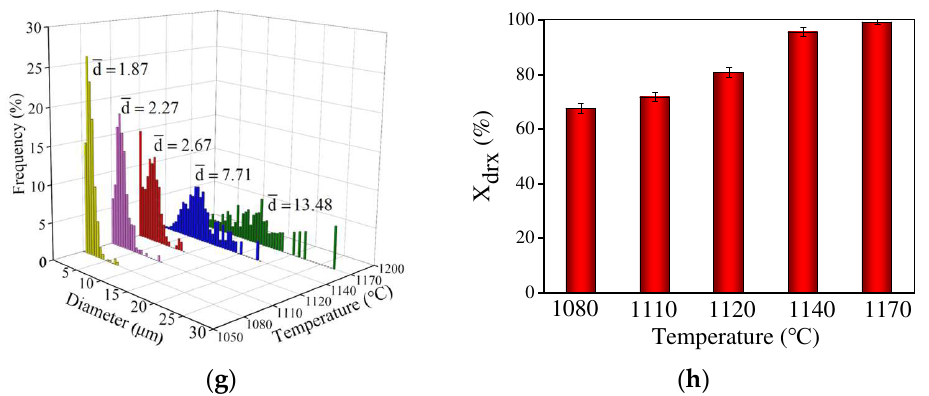
Figure 6. GOS maps of the HIPed superalloy deformed at temperatures of ( a ) 1080 °C; ( b ) 1110 °C [28]; ( c ) 1120 °C; ( d ) 1140 °C; ( e ) 1170 °C; ( f ) the local misorientation angle; ( g ) average grain size distribution; ( h ) area fraction of DRX (the strain rate is 1 s − 1 and true strain is 0.92).